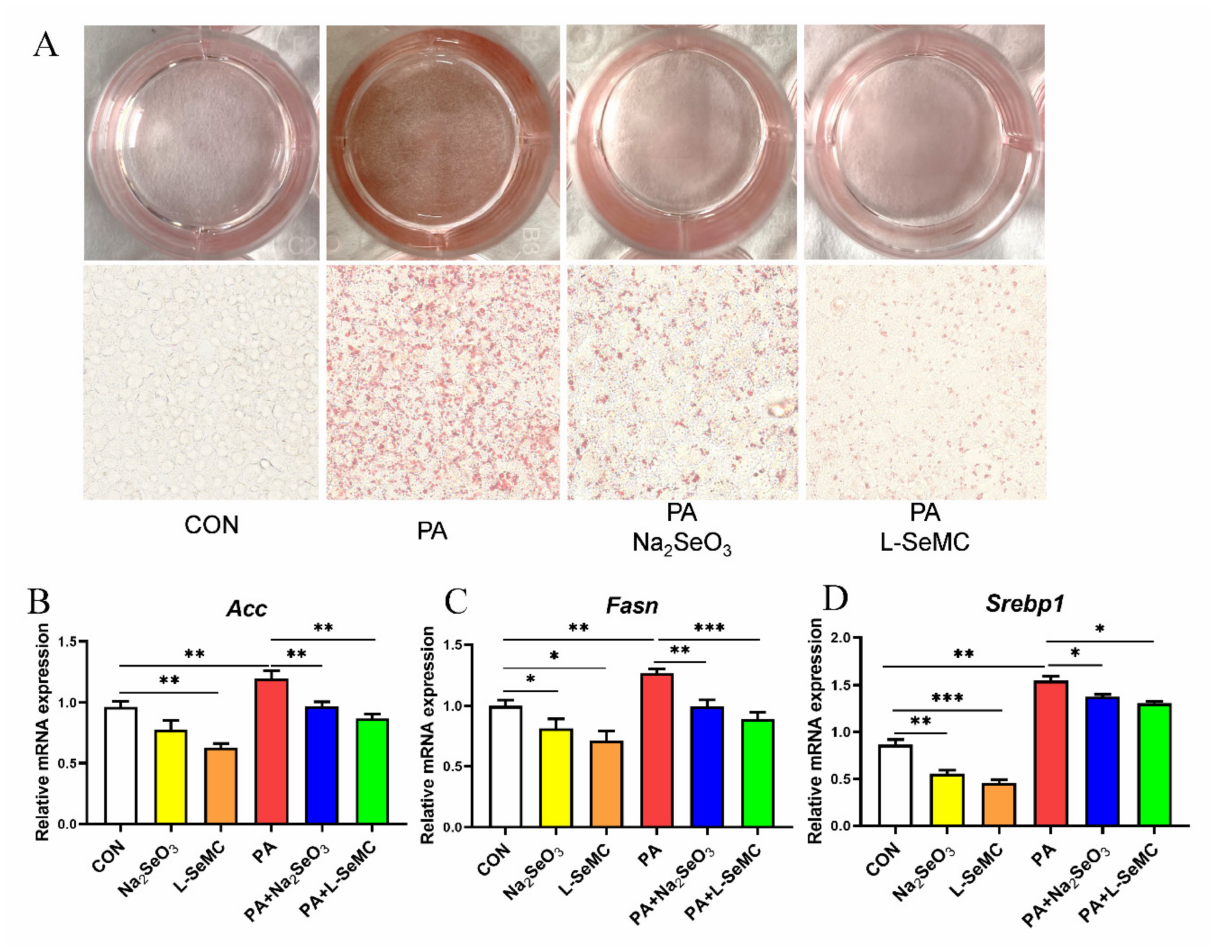
Figure 3. Effects of Na 2 SeO 3 and L-SeMC on lipid accumulation in PA-induced AML-12 cells. ( A ) Oil Red O assay was used to measure lipid accumulation in AML-12 cells after co-treatment with PA with or without Na 2 SeO 3 and L-SeMC for 24 h (400 × magnification). ( B – D ) The mRNA levels of Acc , Fasn , and Srebp1 ( n = 3, *** p < 0.001, ** p < 0.01, * p <